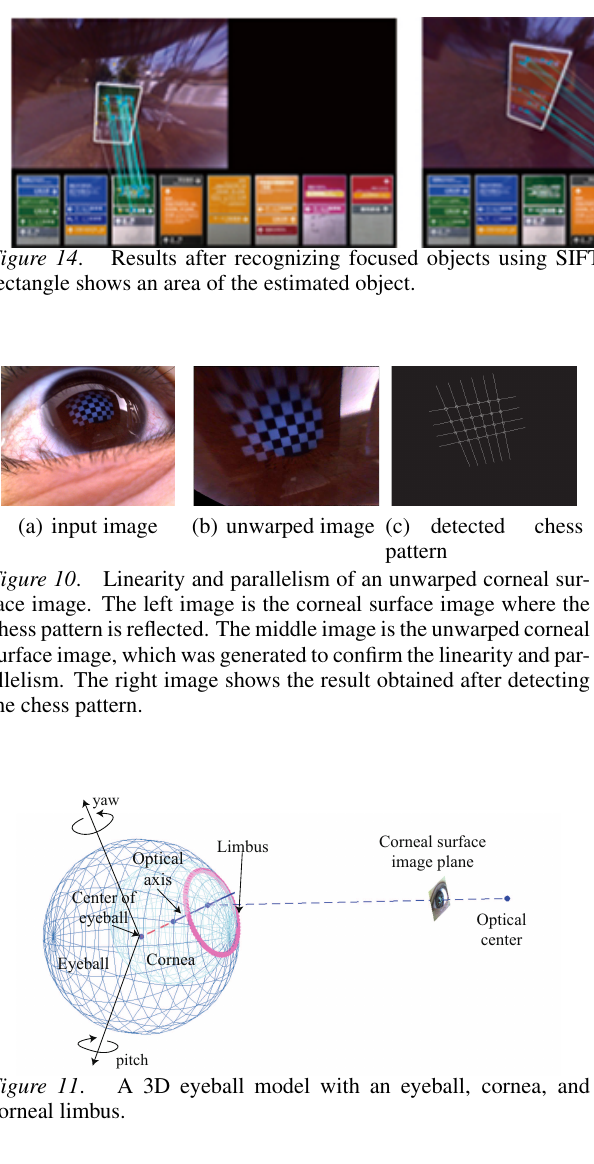
Figure 12 . Algorithm for iris tracking using the 3D eye model. An inverted binary image of an eye (a) and the simulated images of the iris area (b) are used to compute the logical product of these image (c). In addition, the iris area is detected when the maximum value is found in the summed values of the logical product